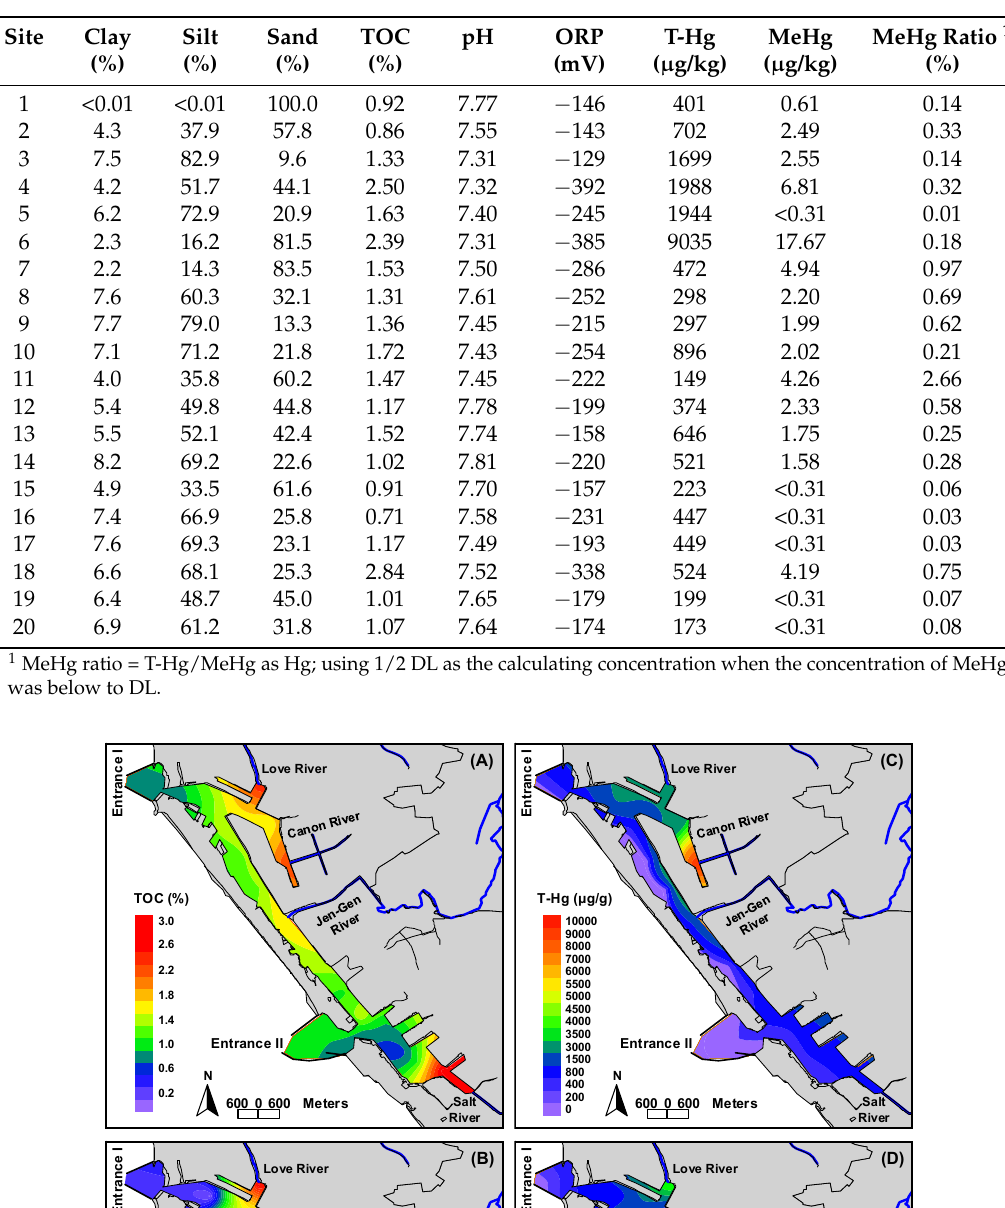
Table 3. The basic characteristics, total mercury (T-Hg), and methylmercury (MeHg) in sediment samples collected from the estuarine and channel of Kaohsiung Harbor.